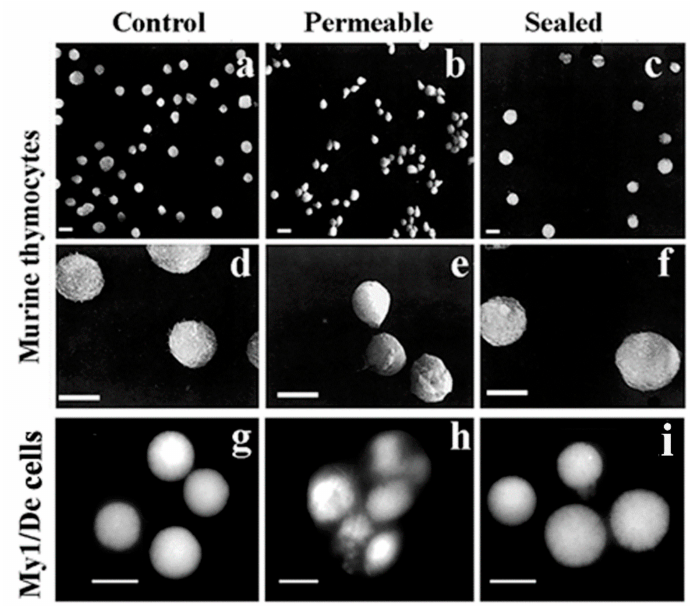
Figure 3. Reversible permeabilization of murine thymocytes and myeloid leukemia (My/De) cells visualized by scanning electron microscopy. ( a ) Control thymocytes were not permeabilized. ( b ) Per- meabilized thymocytes, ( c ) sealed thymocytes permeabilized for 15 min kept in the presence of 4.5 g/v-T150 and hypotonic buffer. ( c ) Sealed in the presence of a K10 medium containing 10% fetal bovine serum. Thymocytes at higher magnification: ( d ) Control cells, ( e ) permeable thymocytes, ( f ) af- ter reversible permeabilization. My1/De cells: ( g ) control, ( h ) after 1 min permeabilization, sealed cells after permeabilization ( i ). Scale bar 5 µ m. Modified with permission of Ref. [12]. Copyright year 1984, Eur. J. Biochem Figure